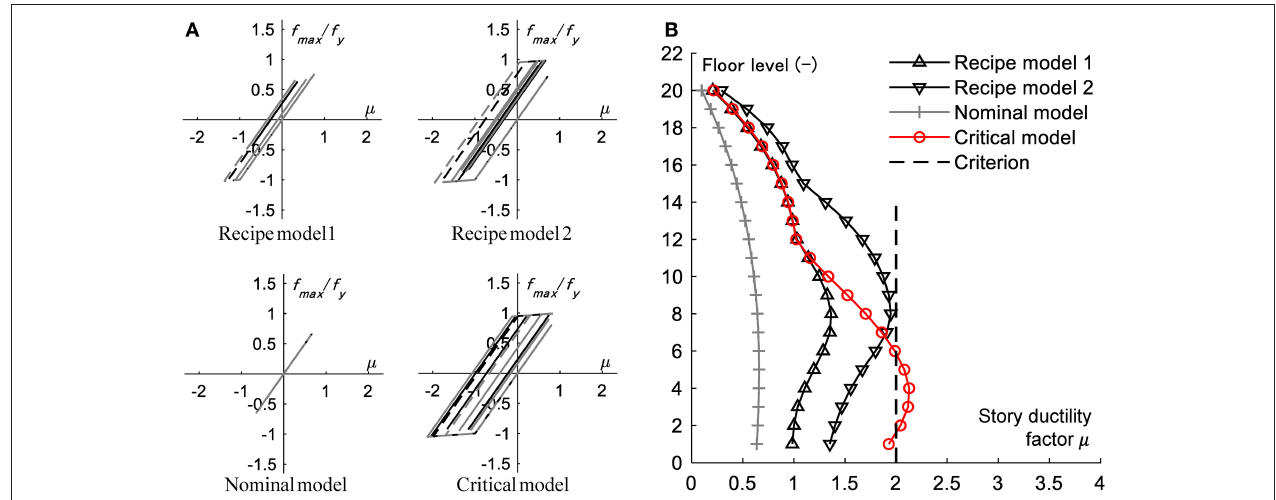
FIGURE 9 | Response for four ground motions. (A) Hysteretic loops in 2, 4, 6, 8th stories for Recipe model 1, 2, Nominal model, and Critical model. (B) Maximum story ductility factors for Recipe model 1, 2, Nominal model, and Critical